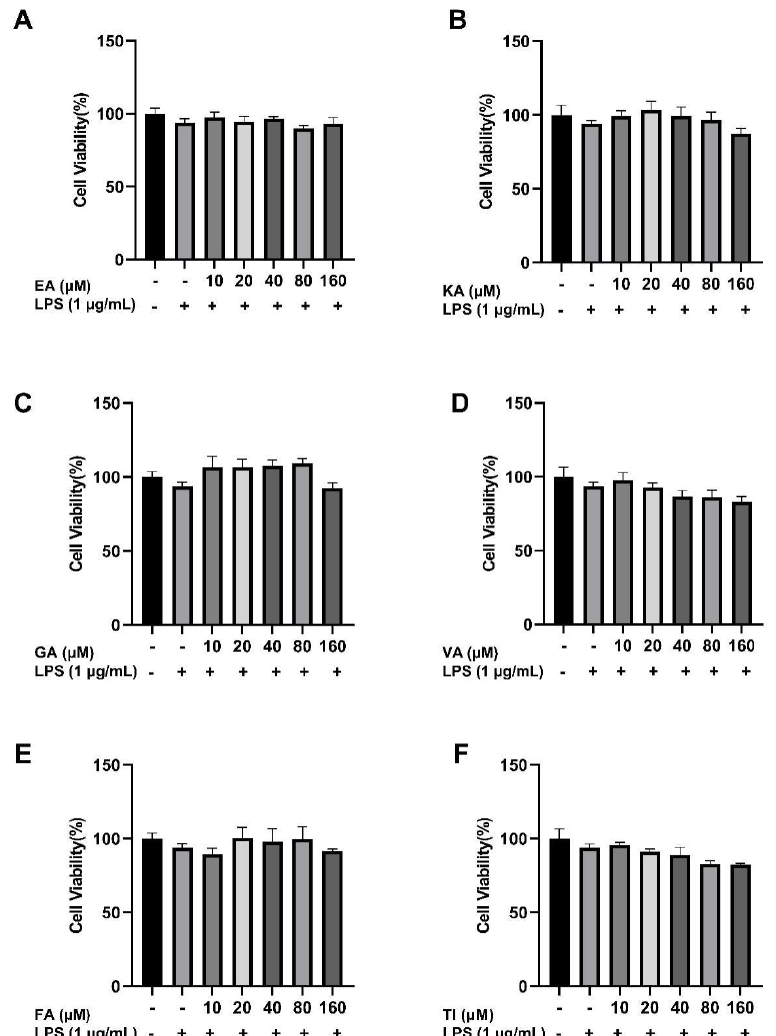
Figure 15. Effect of Ellagic acid ( A : EA), Kaempferol-3-o-rutin glycoside ( B : KA), Gallic acid ( C : GA), Vanillic acid ( D : VA), Ferulic acid ( E : FA), and Tiliroside ( F : TI) at 10, 20, 40, 80 and 160 µ M concen- trations and LPS on BV2 cell proliferation, respectively. − indicates that contain, + indicates does not contain. 2.6.2. Effects of Six Phenolic Compounds on LPS-Induced NO Levels in BV2 Cells